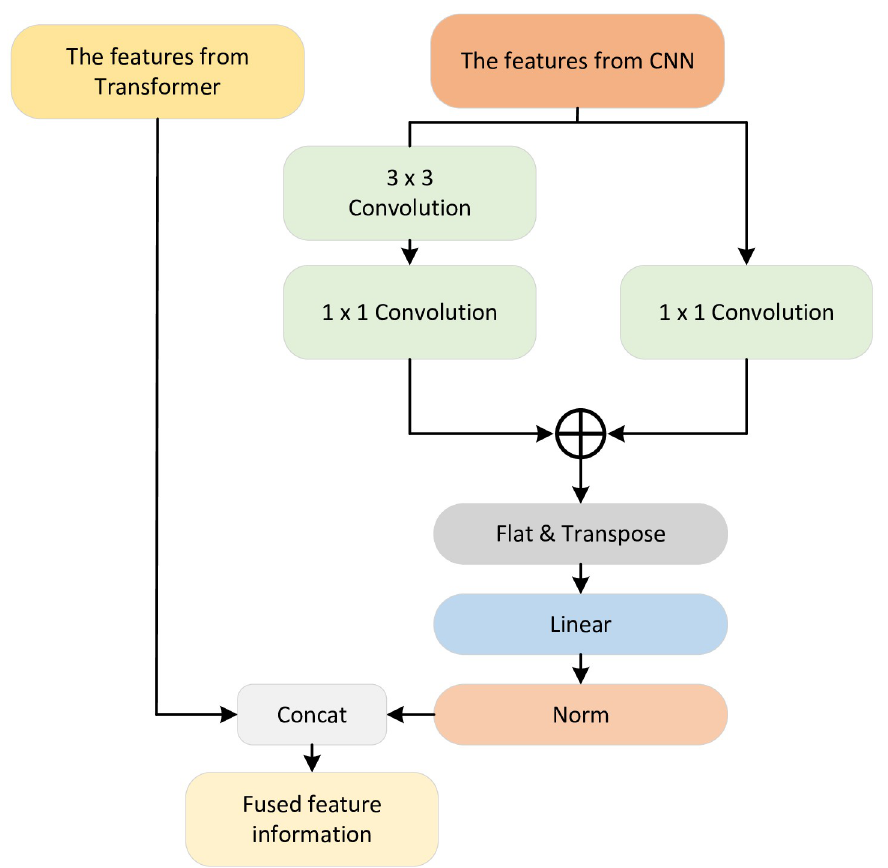
Fig 3. The architecture of CNN and transformer fusion blocks.